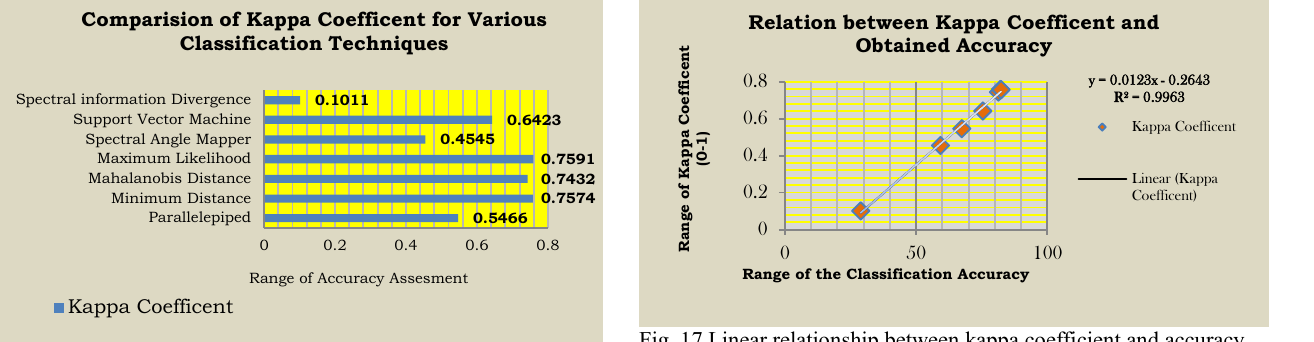
Fig. 17 Linear relationship between kappa coefficient and